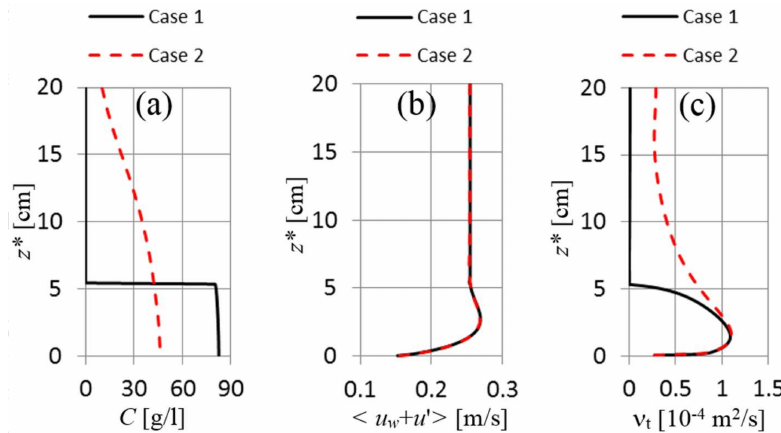
Figure 13. Sensitivity study. Vertical profiles of ( a ) suspended sediment concentration, C ; ( b ) profile of RMS values of horizontal velocity variations, u w + u (cid:48) , and ( c ) vertical eddy viscosity, ν t , after 30 min of simulation. z * is distance from the seabed. Shown are case 1 (solid black lines; S ε = 0) and case 2 (dashed red lines; S b = 0). Sediment stratification effects are essential for lutocline